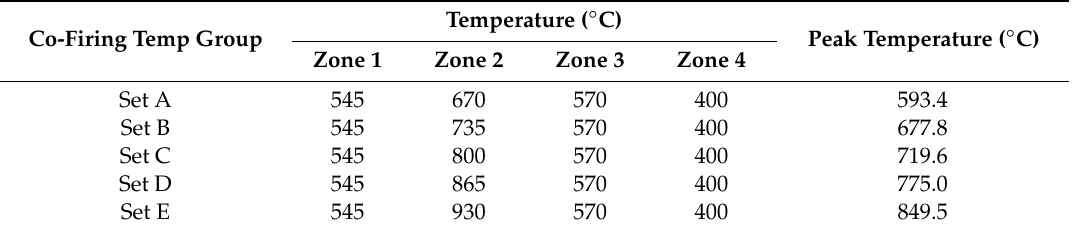
Table 1. Fast-firing temperature profile groups of this